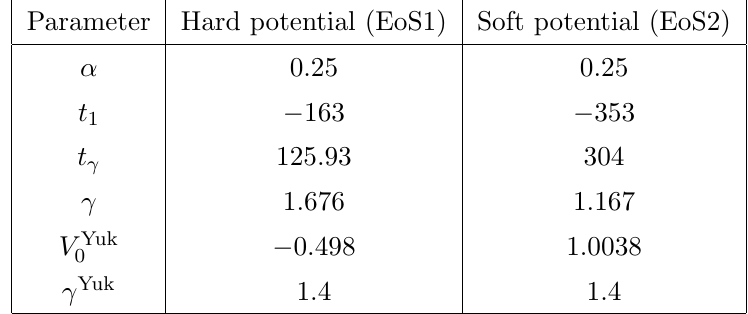
Table 1 . Parameters of the hard and soft mean-(cid:12)eld potentials used in the current version of the